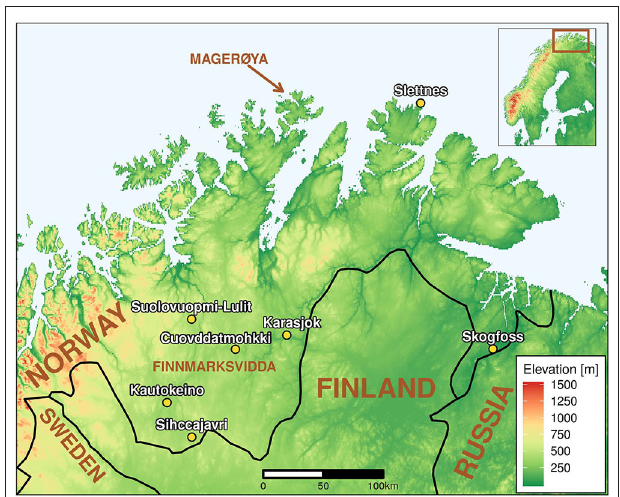
FIGURE 7 | Meteorological stations within the reindeer winter pasture area of Finnmarkvidda at which the data presented here were collected. These are Cuovddatmohki (station number 97350, 286m a.s.l.), Kautokeino (93700, 307m a.s.l.), Karasjok (97250, 131m a.s.l.), Sihccajarvi (93900, 382m a.s.l.), Skogfoss (99500, 55m a.s.l.) and Suolovuopmi (93300, 381m a.s.l.). Data for weather conditions during calving time (May) were collected at Slettnes Lighthouse (96400, 8m